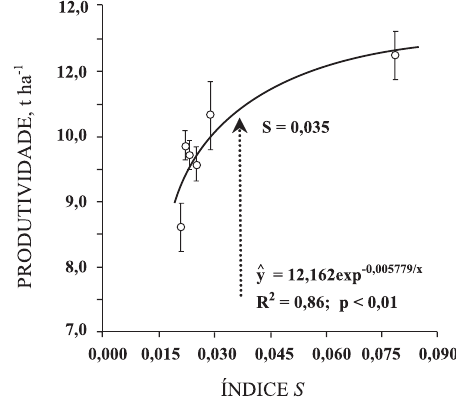
Figura 3. Regressão entre a produtividade de milho e o índice S do Latossolo Vermelho. As barras referem-se aos intervalos de confiança com os erros-padrão das médias.